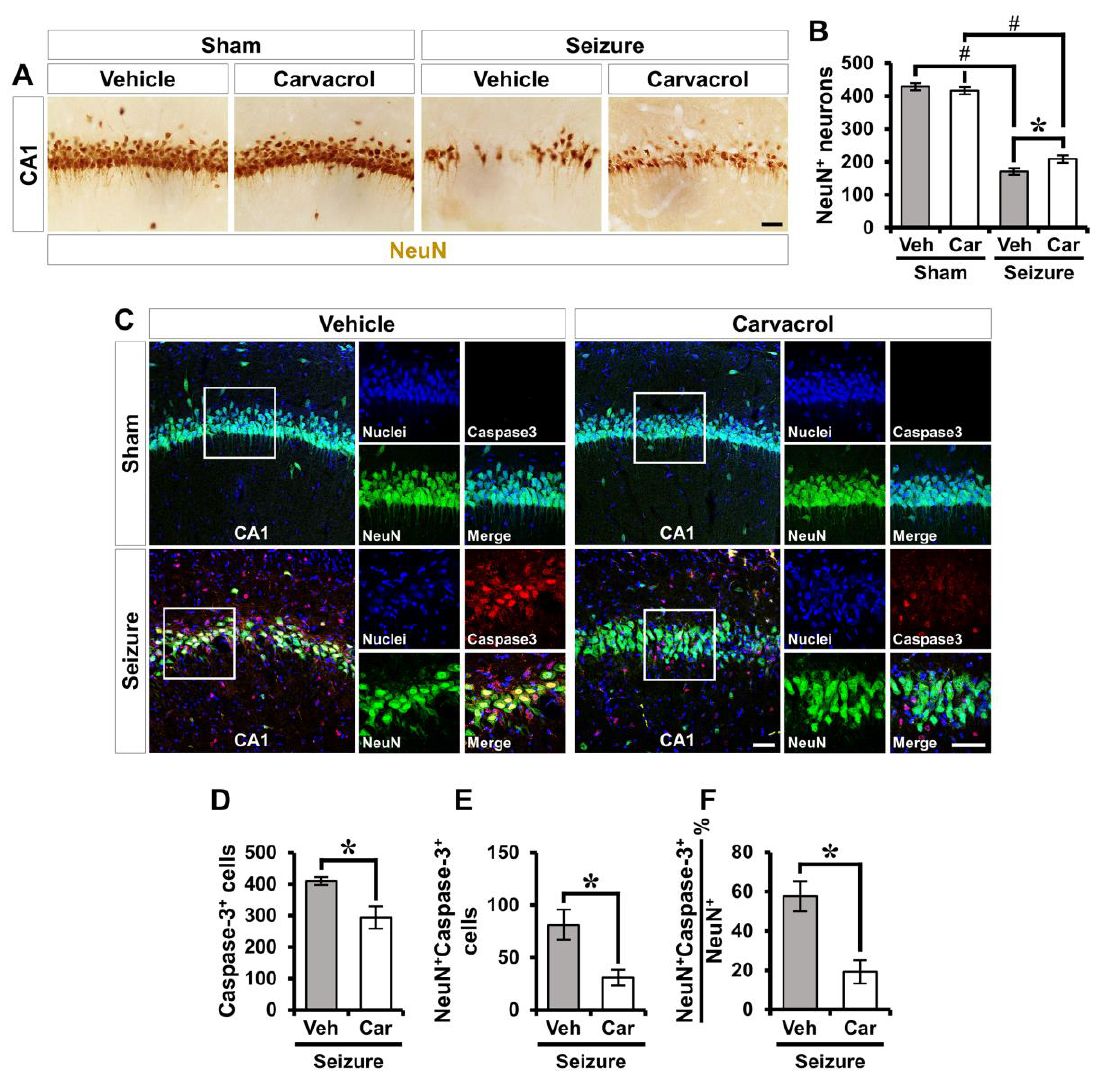
Figure 6. Carvacrol treatment reduces apoptotic neuronal death following pilocarpine-induced SE. ( A ) Representative images showing the expression of NeuN + live neurons in the hippocampal CA1 from the vehicle- and carvacrol-treated groups 1 week after sham or SE. Scale bar, 100 µ m. ( B ) Quantification showing the number of NeuN + neurons as determined in the same hippocampal region (mean ± SEM; n = 6 from each sham group, n = 10 from each seizure group). * p < 0.05 vs. the vehicle-treated group; # p < 0.05 vs. the sham-operated group (Kruskal–Wallis test followed by a Bonferroni post-hoc test; chi square = 23.958, df = 3, p < 0.001). ( C ) Double immunofluorescent images representing the neuronal marker NeuN + cells (green) co-labeled with the cleaved caspase-3 (red) in the hippocampal CA1 from the vehicle- and carvacrol-treated groups after SE. The nuclei are counterstained with DAPI (blue). Scale bar, 50 µ m. ( D – F ) Quantification of the number of caspase-3 + ( D ) and NeuN + Caspase-3 + cells ( E ) and the percent of NeuN + Capase-3 + cells over total NeuN + cells ( F ) as determined in the same hippocampal region (mean ± SEM; n = 4–6 per group). * p < 0.05 vs. the vehicle-treated group (Mann–Whitney U test: Figure 6D: z = 2.082, p = 0.041; Figure 6E: z = 2.242, p = 0.026; Figure 6F: z = 2.882, p =